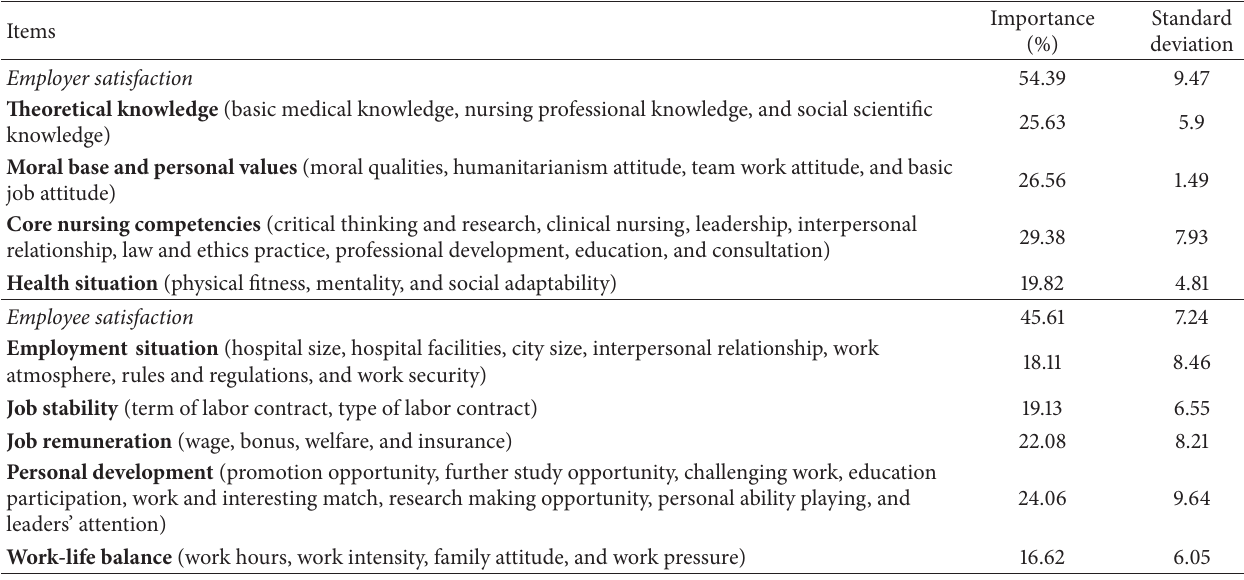
Table 1: Items of tools for employment relevant satisfaction.